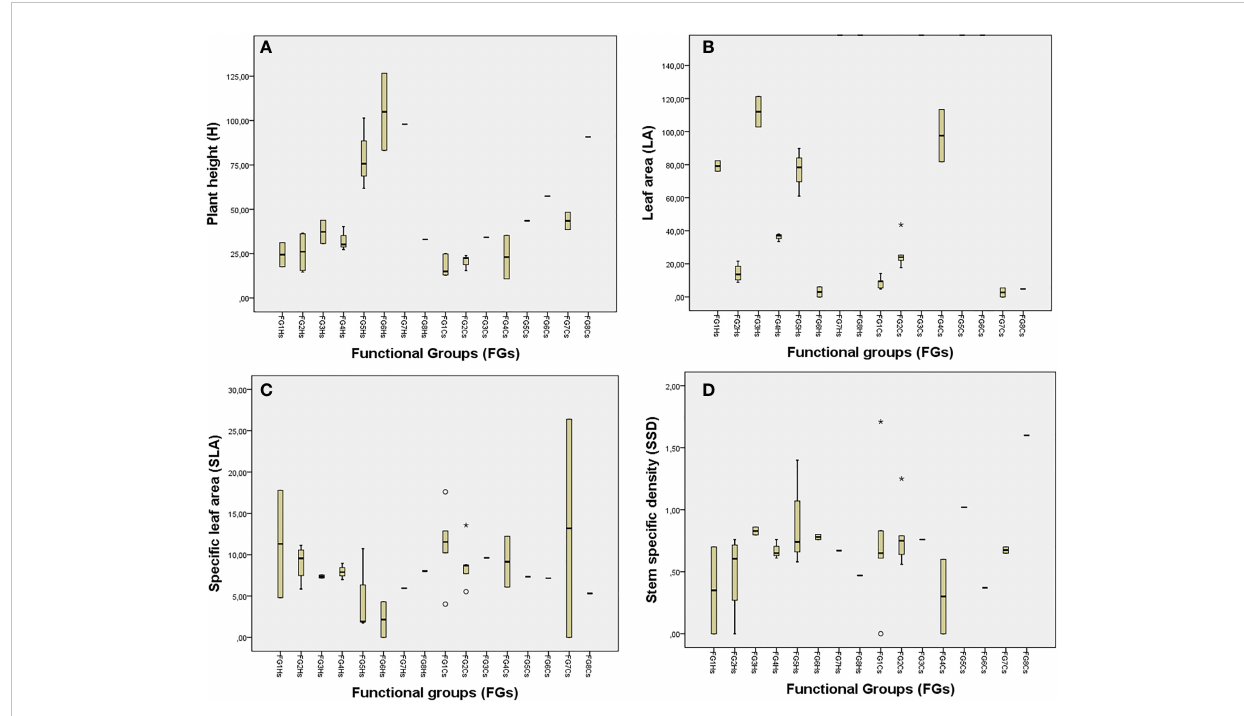
FIGURE 2 Mean trait values for: (A) H (plant height, cm), (B) LA (leaf area, mm 2 ), (C) SLA (speci fi c leaf area, mm 2 /mg), and (D) SSD (stem speci fi c density, mg/ mm³). The traits are grouped into the obtained functional groups at each shrubland. Halimium shrubland (HS) and Cistus shrubland